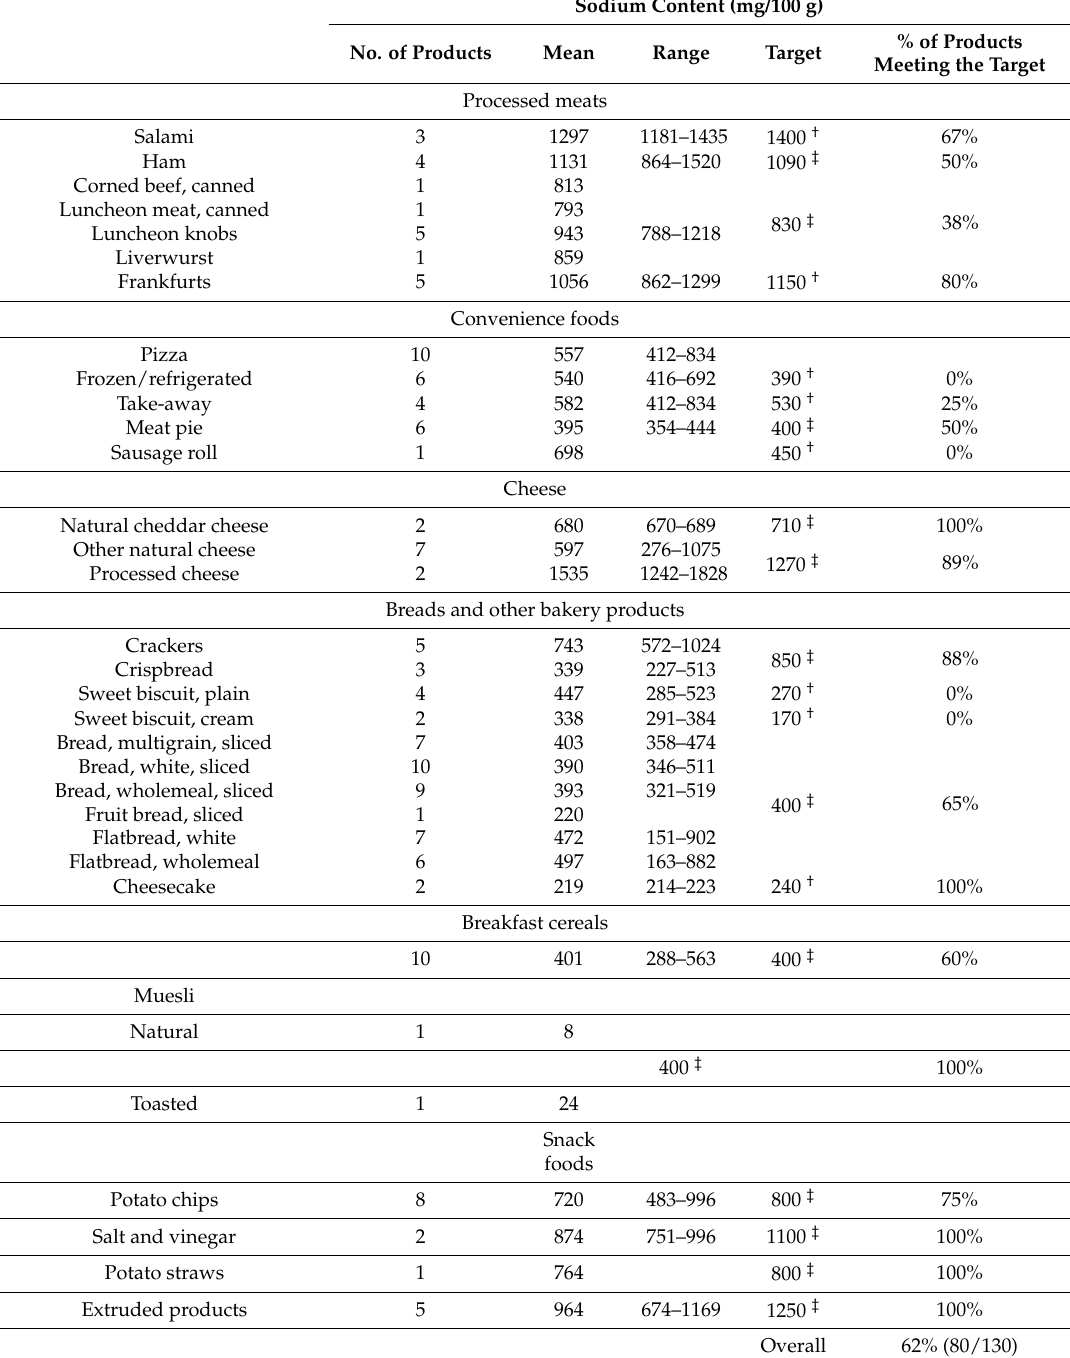
Table 1. Sodium content of Australian processed foods in